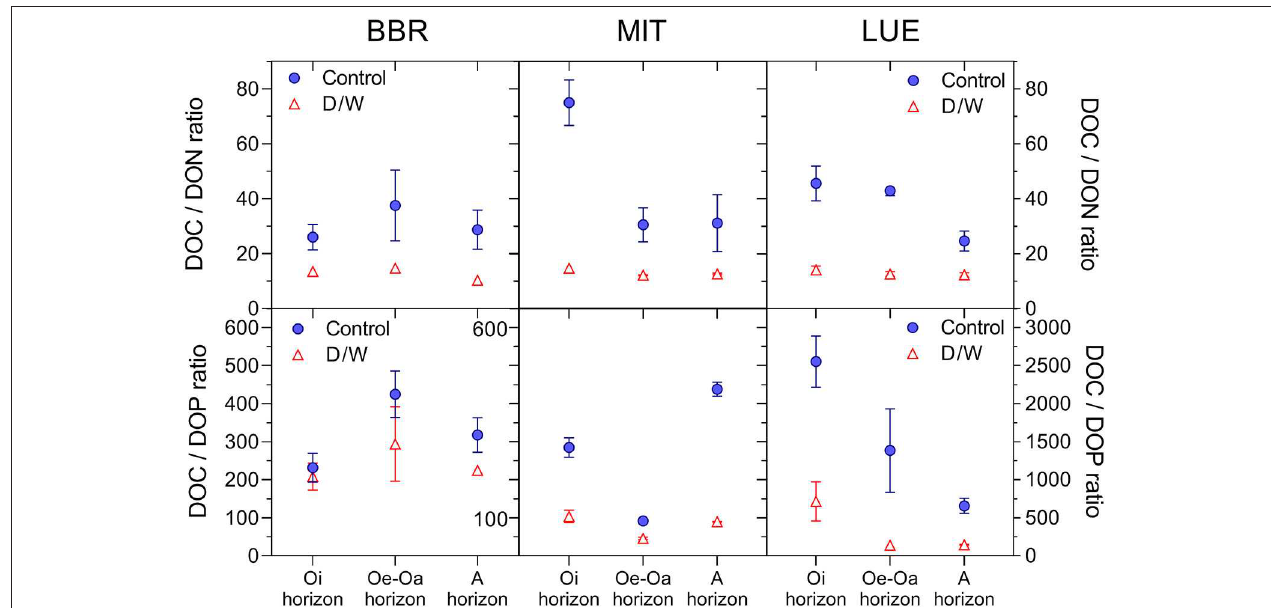
FIGURE 7 | Effects of the drying-rewetting on DOC:DON ratios and DOC:DOP ratios in leachates collected after the second dry spell in week 19. Means and standard errors of four replicates.